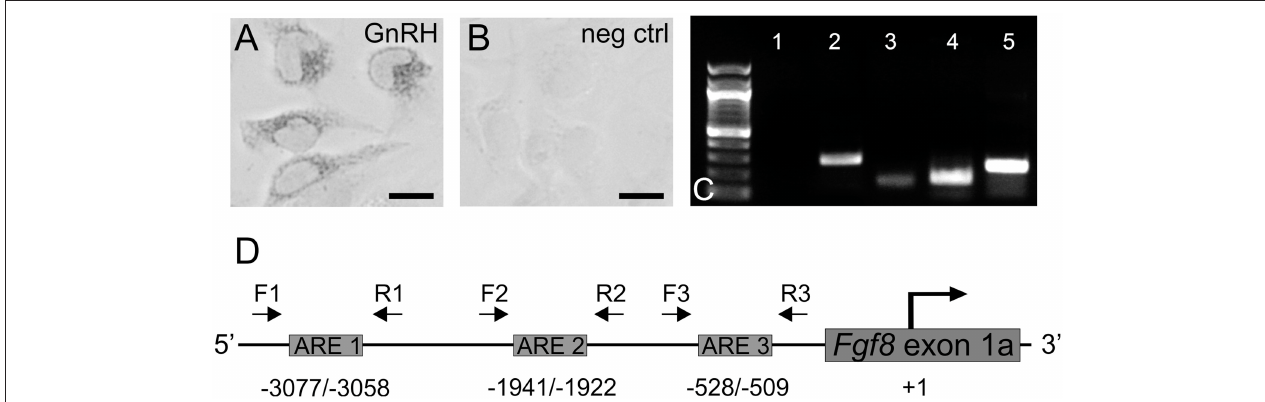
FIGURE 1 | (A) Immunocytochemistry of GnRH expressing GT1-7 neurons (gray) and (B) negative control (no primary antibody). Scale bar = 25 µ m. (C) PCR in GT1-7 neurons. lane 1, no cDNA; lane 2, AR; lane 3, Fgf8 ; lane, FgfR1 ; lane 5, GnRH . (D) Analysis of the mouse Fgf8 5 ′ -UTR region [5 Kb upstream of the translation start site ( + 1)] with Matinspector (Genomatix) revealed the presence of three ARE sites upstream of the translation start site with a shared consensus sequence. Relative position of F (forward) and R (reverse) flanking primer pairs (1, 2, 3) used to detect ARE 1 ( − 3077/ − 3058), ARE 2 ( − 1941/ − 1922), and ARE 3 ( − 528/ −